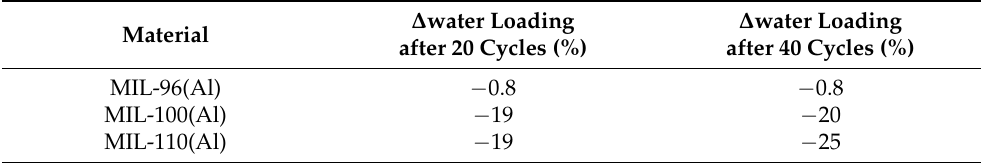
Table 1. Water loading data for all three studied materials after 20 and 40